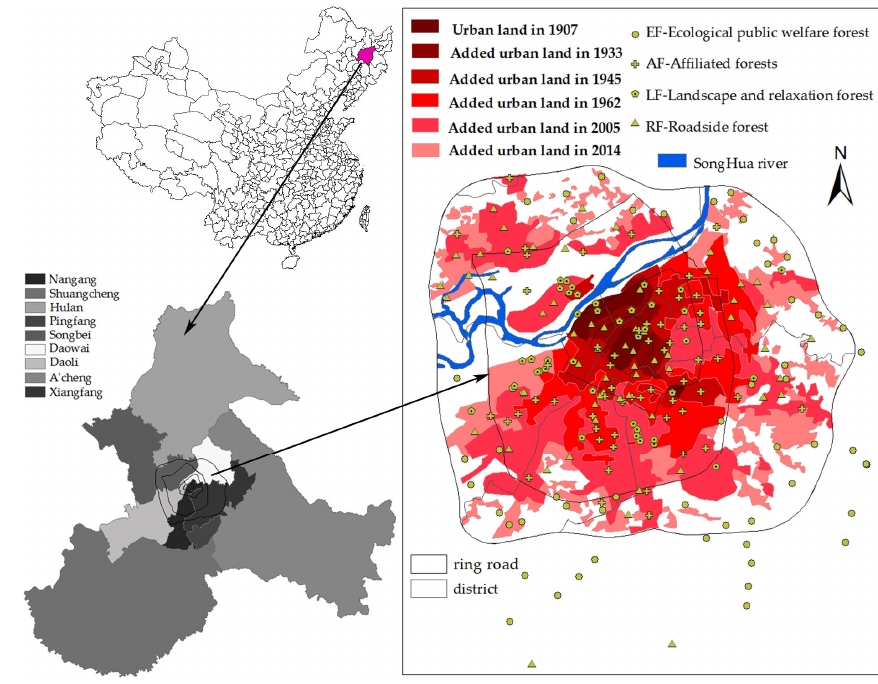
Figure 1. Location of the study area showing Harbin City in northeastern China, and the distribution of sampling plots in the Harbin City region.